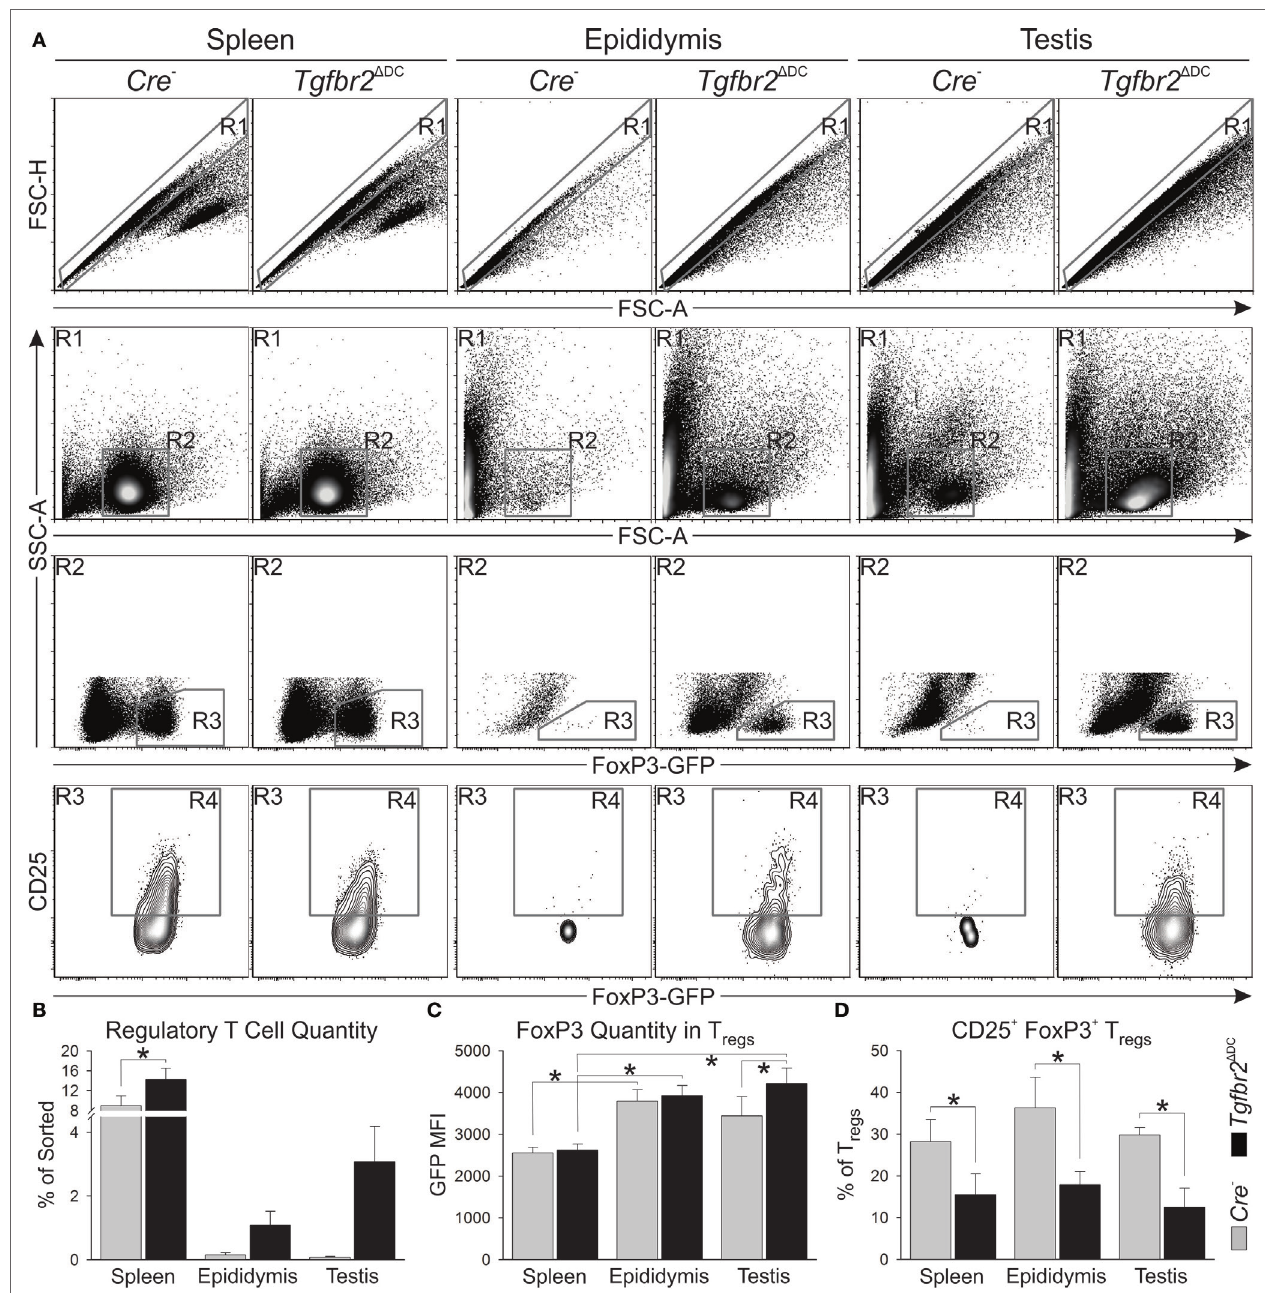
FigUre 4 | Loss of transforming growth factor beta (TGF β ) signaling in dendritic cells (DCs) leads the epididymis and testis to contain regulatory T cells (T regs ) at numbers much greater than at steady state. (a) Typical flow cytometry outcomes from CD4 + sorted splenic, epididymal, and testicular cell suspensions, and the gating strategy used are shown. T reg numbers and the estimates of FoxP3 expression were defined with R3. CD25 + FoxP3 + T regs were quantified with R4. (B) T reg increases were detected in all the Tgfbr2 Δ DC tissues tested. (c) Estimates of FoxP3 expression in T regs from the tissues tested. (D) CD25 + FoxP3 + T regs were significantly reduced in all Tgfbr2 Δ DC tissues tested. N = 3 (pairs of Cre − and Tgfbr2 Δ DC littermate males, age 9–10 weeks); p ≤ 0.05. All samples were recorded to exhaustion and the average number of events in R1 across all samples was